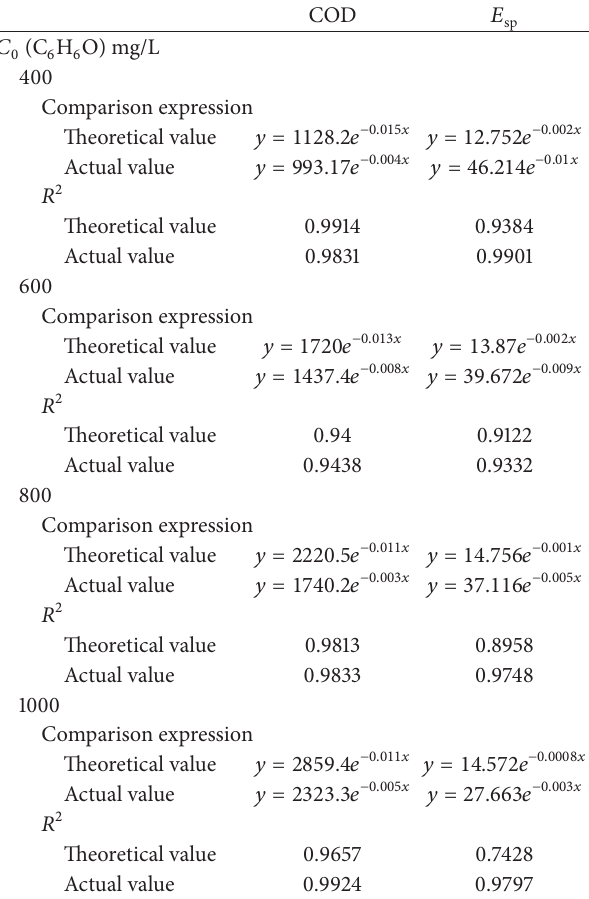
Table 1: Relation and related coefficient to treat different concentra- tion phenol